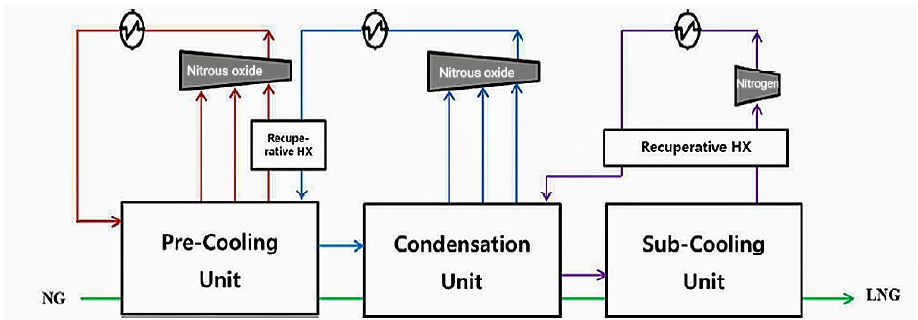
Figure 6. The proposed N 2 O-N 2 O-N 2 cycle for natural gas liquefaction [37]. Reprinted